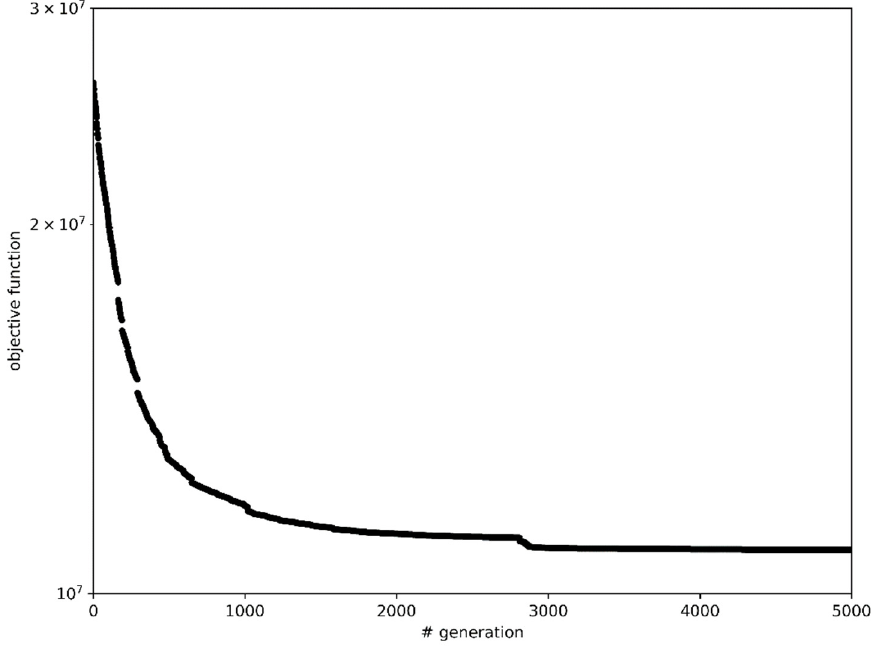
Figure 3. Convergence curve of the optimization of the final design, with the number of generations on the x -axis (log-scale) and the performance on the y -axis.